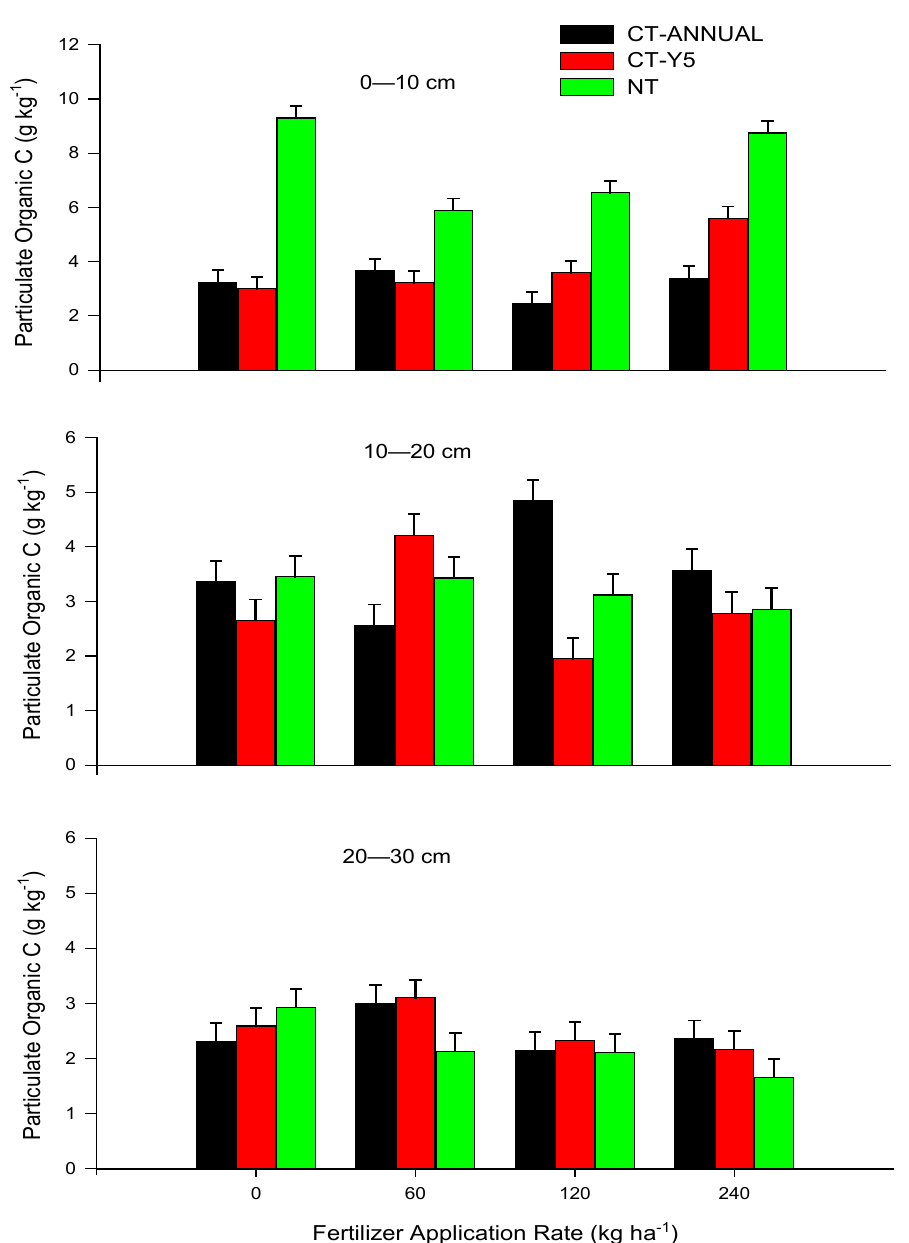
Figure 4. Particulate organic carbon with soil depths and fertilizer application (kg N ha −1 ) for three tillage techniques.